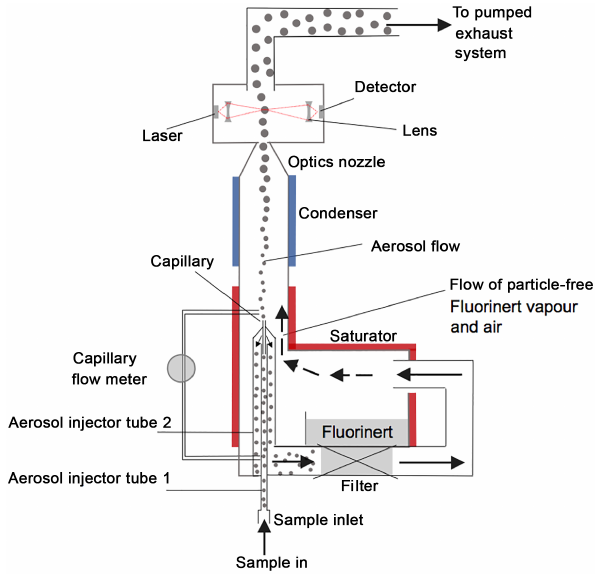
Figure 2. Schematic of a CPC unit of the NMASS. The sample flow is split between aerosol flow and sheath flow. Aerosol flow is selected from the centre of the sample flow stream and passed through a capillary to reduce losses. Sheath flow is passed through a filter to remove particles, over a warm Fluorinert bath to pick up the vapour and then into the condenser. In the condenser, Fluorinert vapour in the sheath flow diffuses into the aerosol flow and con- denses onto particles, growing them to optically detectable sizes. The grown particles then pass through the optics block, consisting of a laser aligned with a lens, beam-block, and detector. The mea- sured flow across the capillary and the counts in the optical detector are used to calculate the concentration of the particles. Dimensions are given in the Supplement, Table